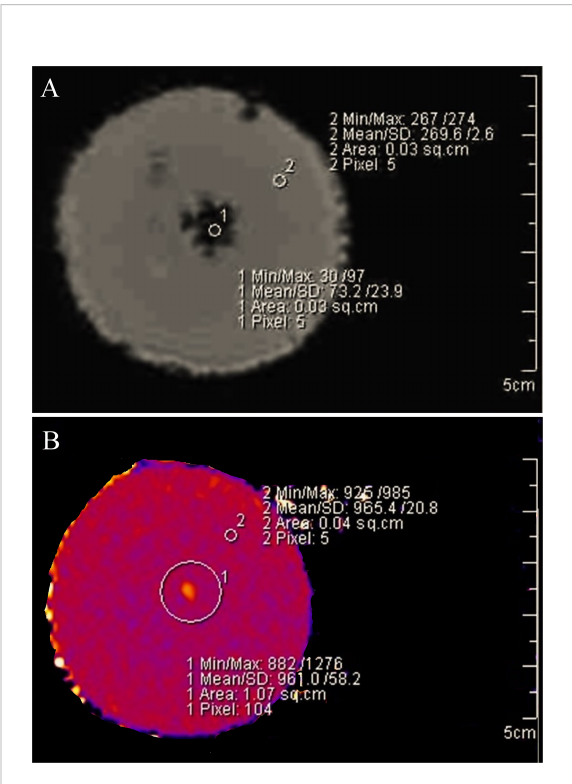
FIGURE 7 Susceptibility-weighted imaging and T 1 relaxometry mapping. A residual bubble cloud appears to develop after HIFU sonications and likely contributes to the heat enhancement. (A) 0.3% v:w F 8 TAC 18 -PFOB gel phantom about one hour after HIFU heating during hydrophone recordings. The susceptibility effect was not seen in the control samples and disappeared within one week from the F 8 TAC 18 -PFOB sample. These measurements were performed after HIFU heating during hydrophone spectra recordings. (B) T 1 hyperintensity was visible with relaxometry